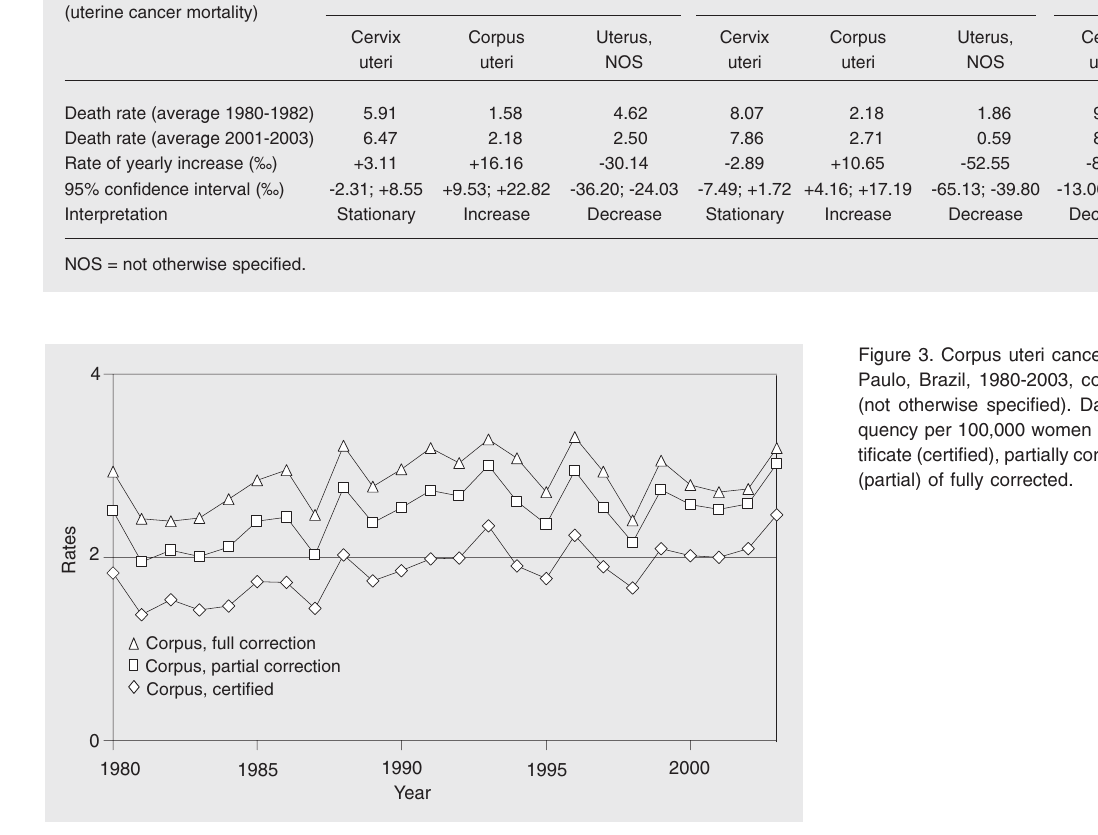
Table 1. Magnitude and trends of uterine cancer mortality in São Paulo, Brazil, 1980-2003. Magnitude and